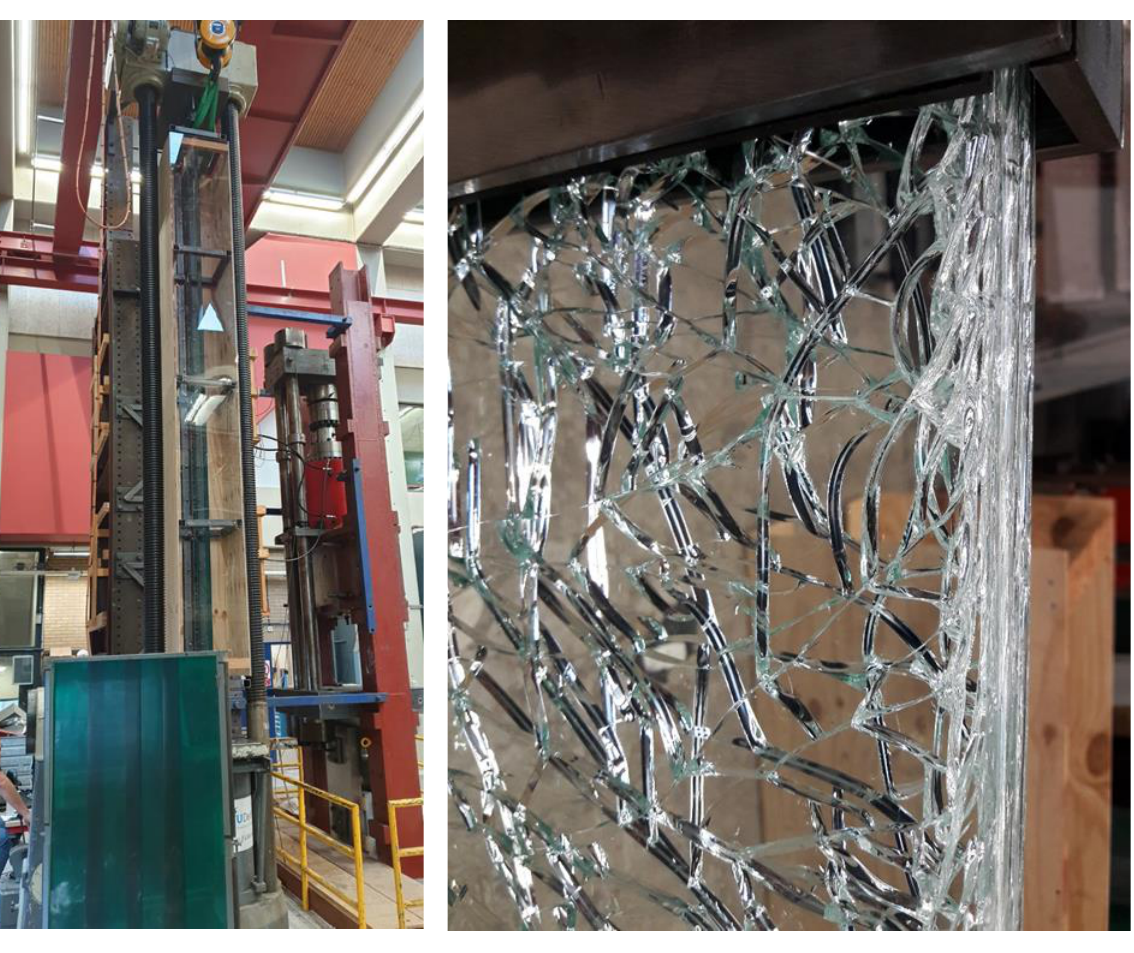
Fig. 10 column in test machine. Fig. 11 column after damage on